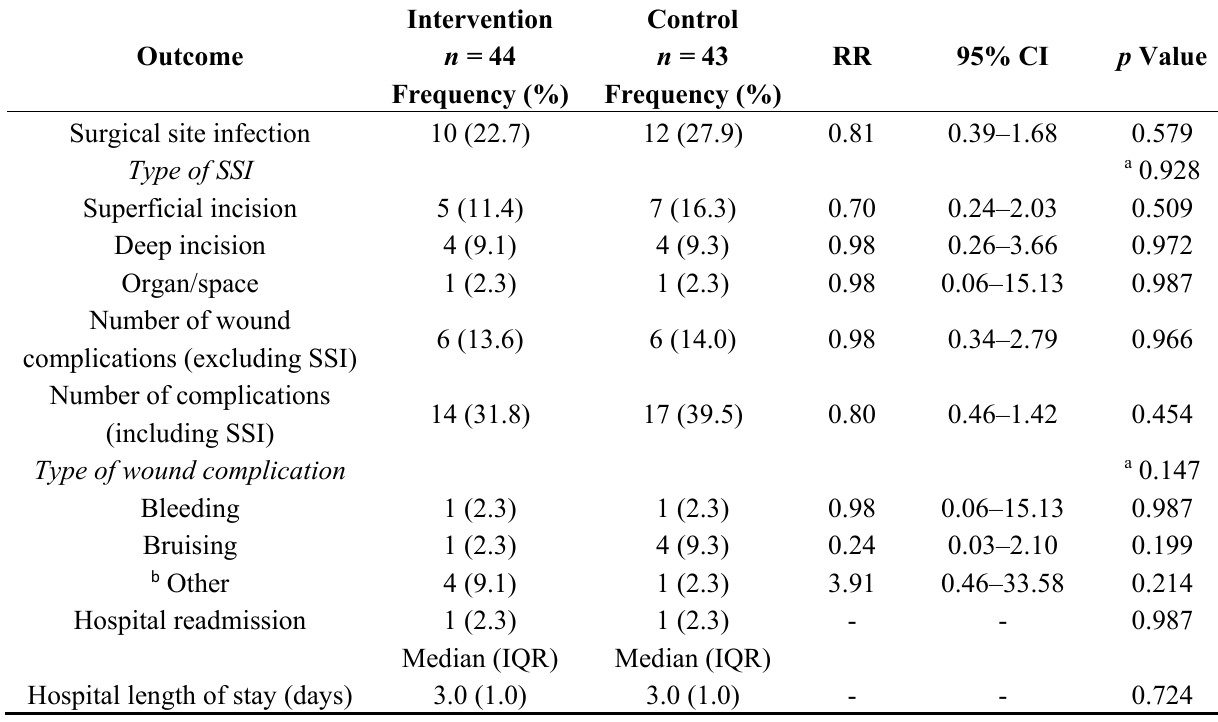
Table 2. Relative Risk of Outcomes ( n = 87).